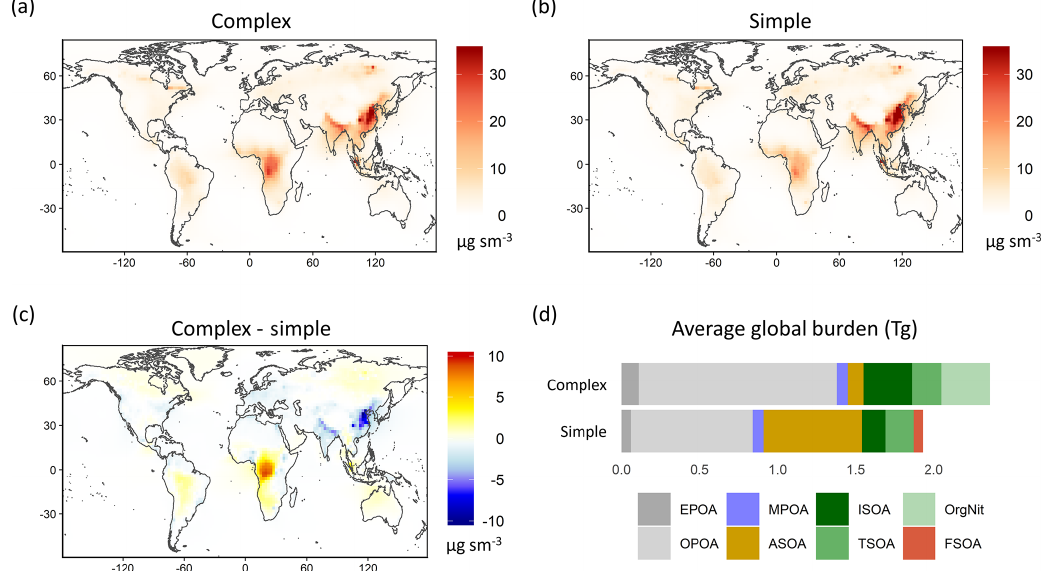
Figure 4. Global map of simulated OA surface concentrations in 2013 for the (a) complex and (b) simple schemes; panel (c) illustrates the difference in OA surface loadings between the complex and simple schemes. Panel (d) displays the total global burden for the individual OA species from both schemes averaged over 2013. Refer to Sect. 3 for details on model sampling and